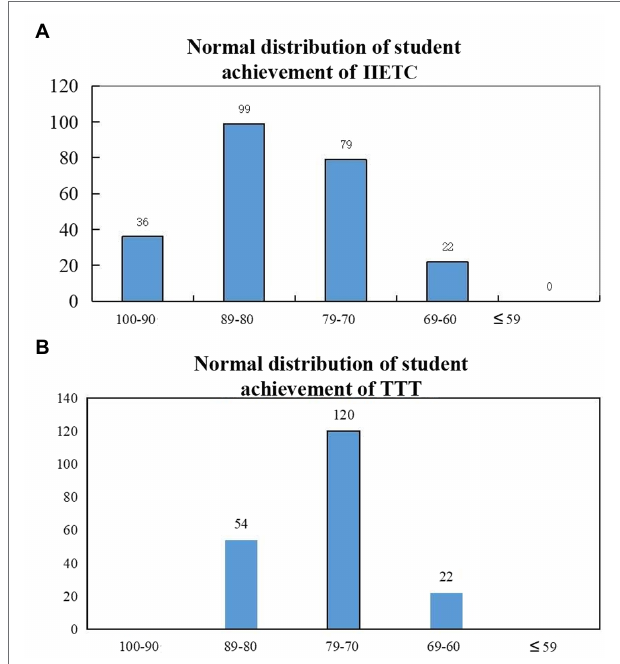
FIGURE 5 | Normal distribution of student achievement. (A) IIETC culture conditions; (B) TTT culture conditions.